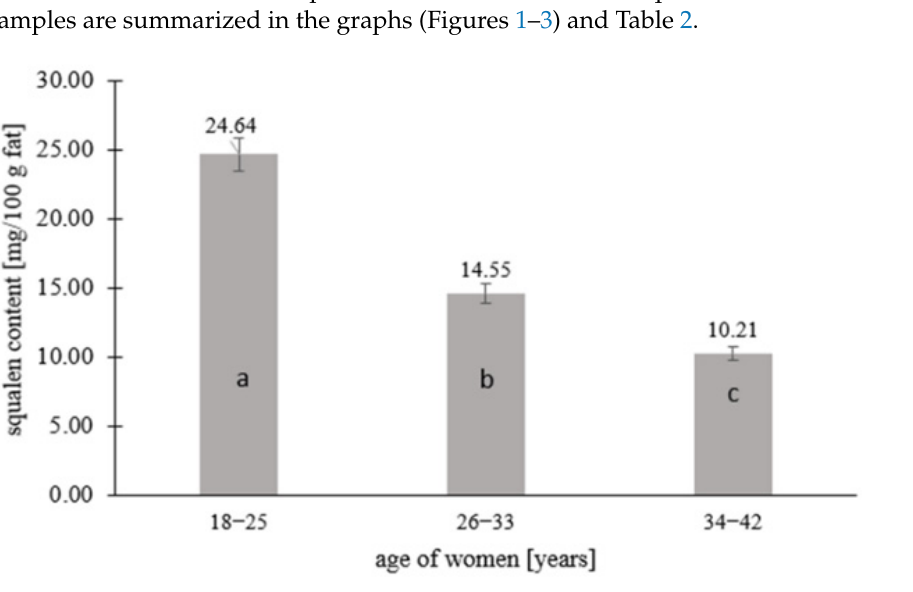
Figure 1. Squalene content in human milk in relation to the age of lactating women. Means followed by a different letter (a, b, c) are significantly different ( p < 0.05).